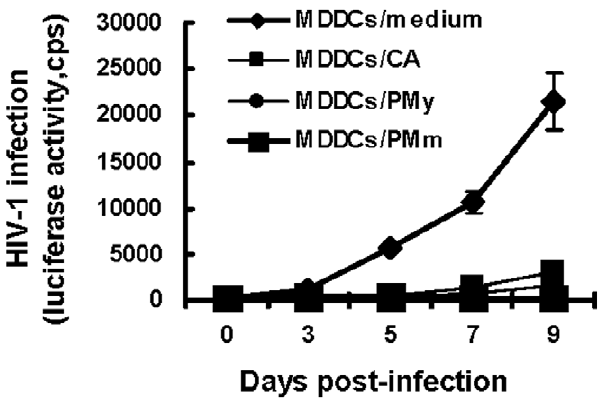
Figure 2. HIV-1 infection is blocked in MDDCs after fungal stimulation. Immature MDDCs were treated separately with heat- killed fungus species C. albicans , PMy and PMm or control medium for 48 h, and then were incubated with single-cycle luciferase reporter virus HIV-Luc/JRFL (5 ng of p24 gag ) for 2 h. After washing, HIV-1-pulsed MDDCs were incubated and harvested at the indicated times, and HIV-1 infection was detected by measuring the luciferase activity in cell lysates. Results of one representative experiment out of three are shown. All data are mean 6 standard deviation (SD).cps, counts per